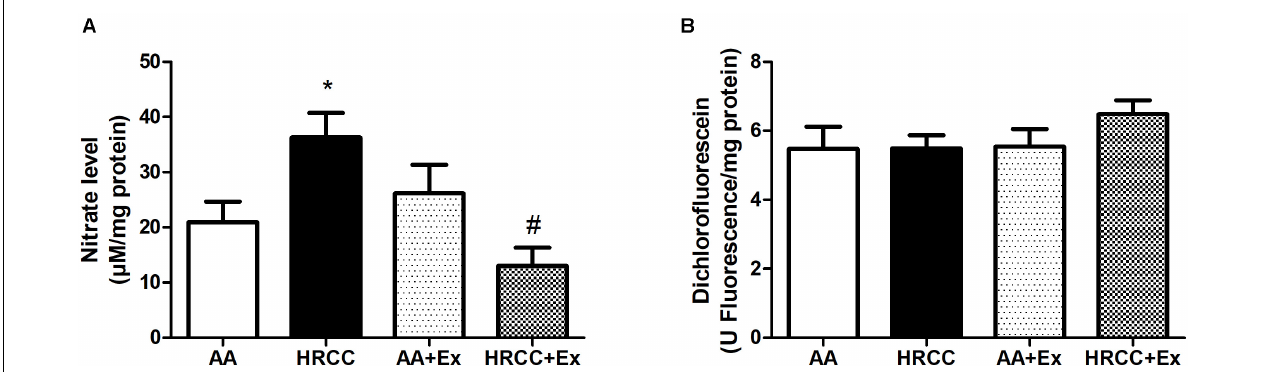
FIGURE 4 | Effect of combined exercise on oxidative stress parameters in quadriceps of mice exposed to hand-rolled cornhusk cigarette (HRCC) smoke. The values of nitric oxide (A) , 2 (cid:48) ,7 (cid:48) -dichlorofluorescein (B) are shown as the mean and standard error of the mean and were analyzed statistically using two-way ANOVA, followed by the Newman–Keuls test. The groups were considered different when p ≤ 0.05* (difference in relation to the ambient air, # difference in relation to HRCC).